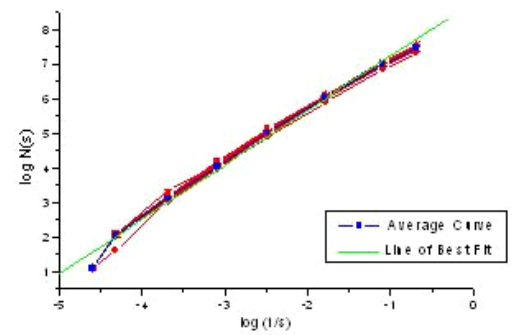
( s ) vs log ( N ( s )) plot for the SSM of face Fig. 2. The log 10 10 image of the person in AT & T face database